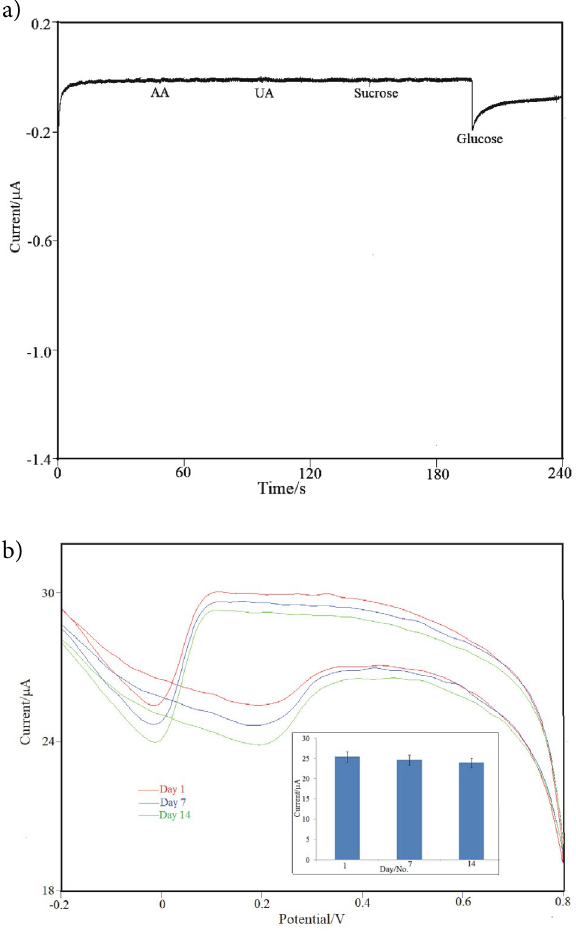
Figure 10. (a) Effect of interfering species on Au/PANI/Pt electrode in presence of 1 mM glucose in 0.1 M NaOH. (b) The current re- sponse of Au/PANI/Pt electrode recorded on Day 1, Day 7, and Day 14. Insert shows bar graph plotted for response current obtained over 3 weeks (with SD error bars).